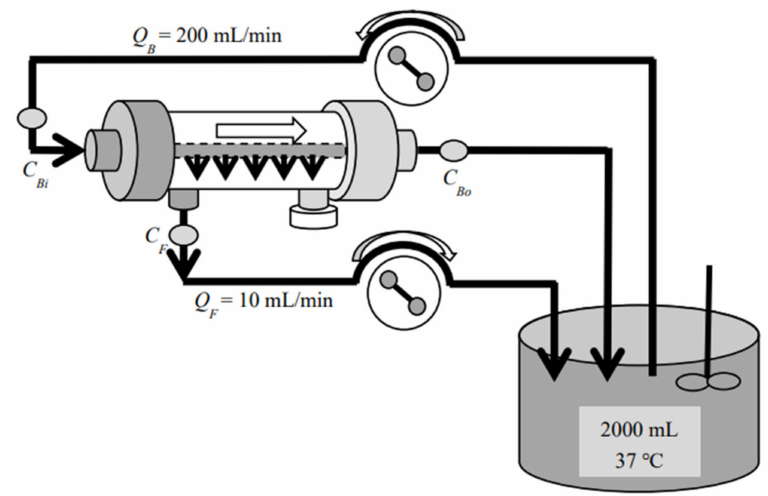
Figure 1. Test circuit for the forward (In-to-Out) ultrafiltration